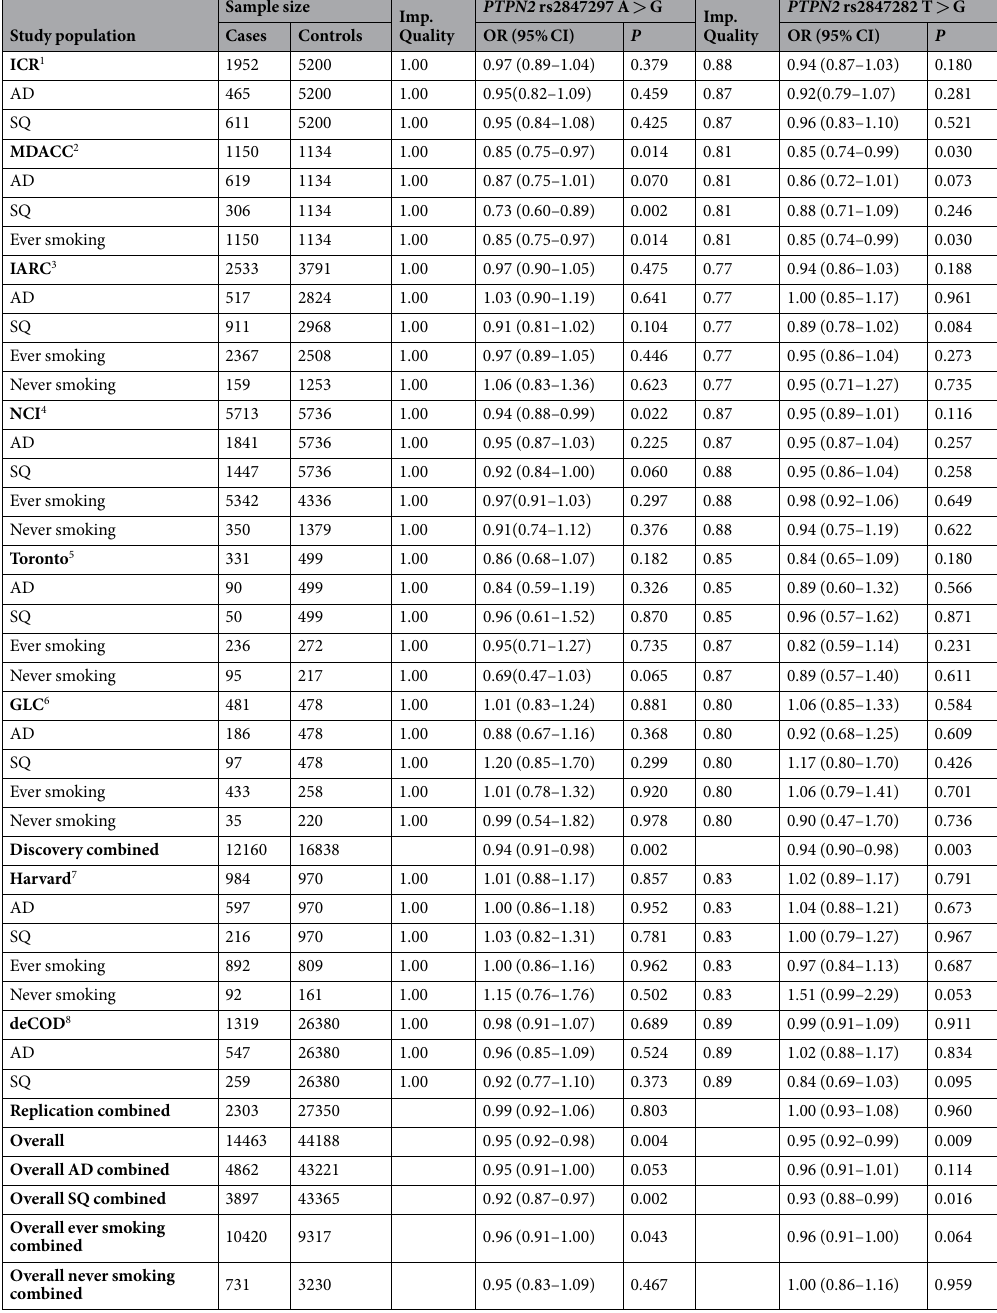
Table 2. Summary of the association results of two SNPs in the eight lung cancer GWAS studies. AD: adenocarcinoma, SQ: squamous cell carcinoma. The combined OR and P value were estimated using a fixed- effects model. 1 ICR: the Institute of Cancer Research Genome-wide Association Study, UK. 2 MDACC: the